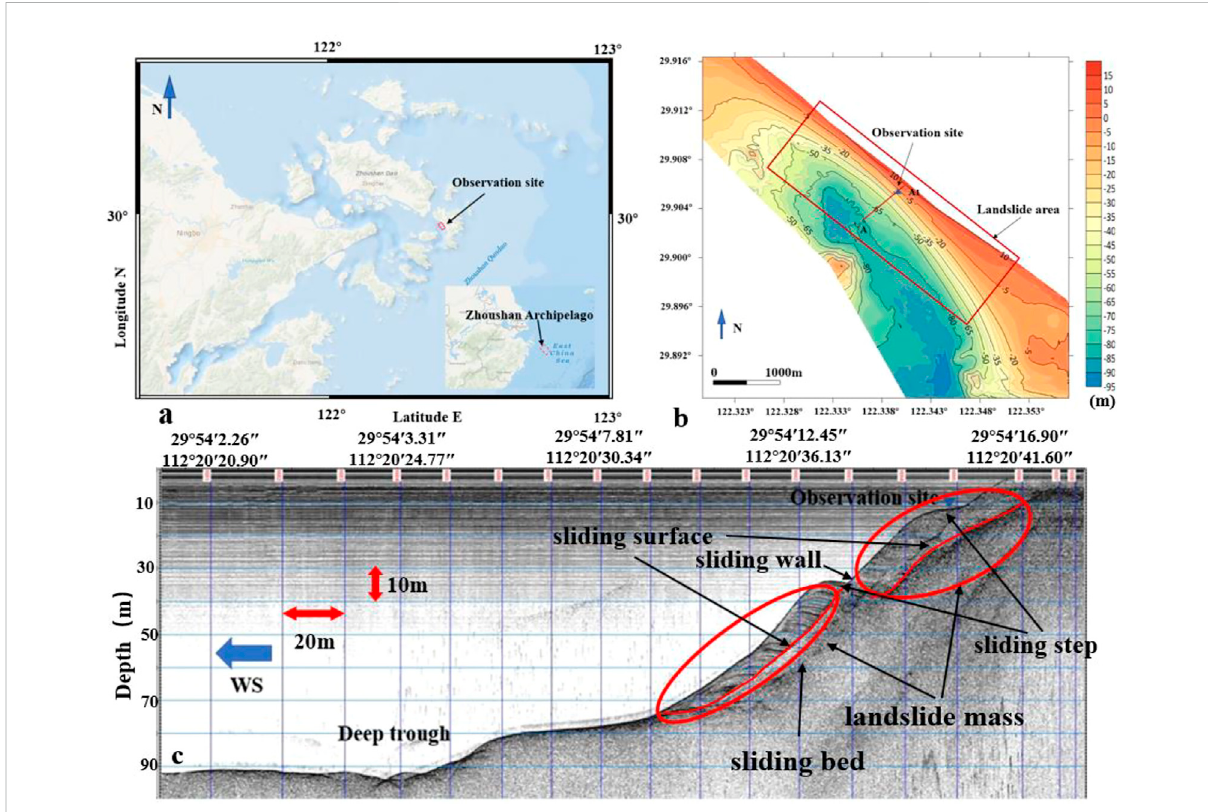
FIGURE 1 Geographical location map, water depth topographic map, and shallow stratum pro fi le of the study area. (A) Shows the map of the Zhoushan archipelago, China, with the Zhujiajian study area marked with a red rectangle. (B) Shows the multibeam topographic map of study area with the observation site highlighted within the blue triangle. (C) Shows subbottom pro fi ling of a scarp near the observation site denoted by a blue triangle.